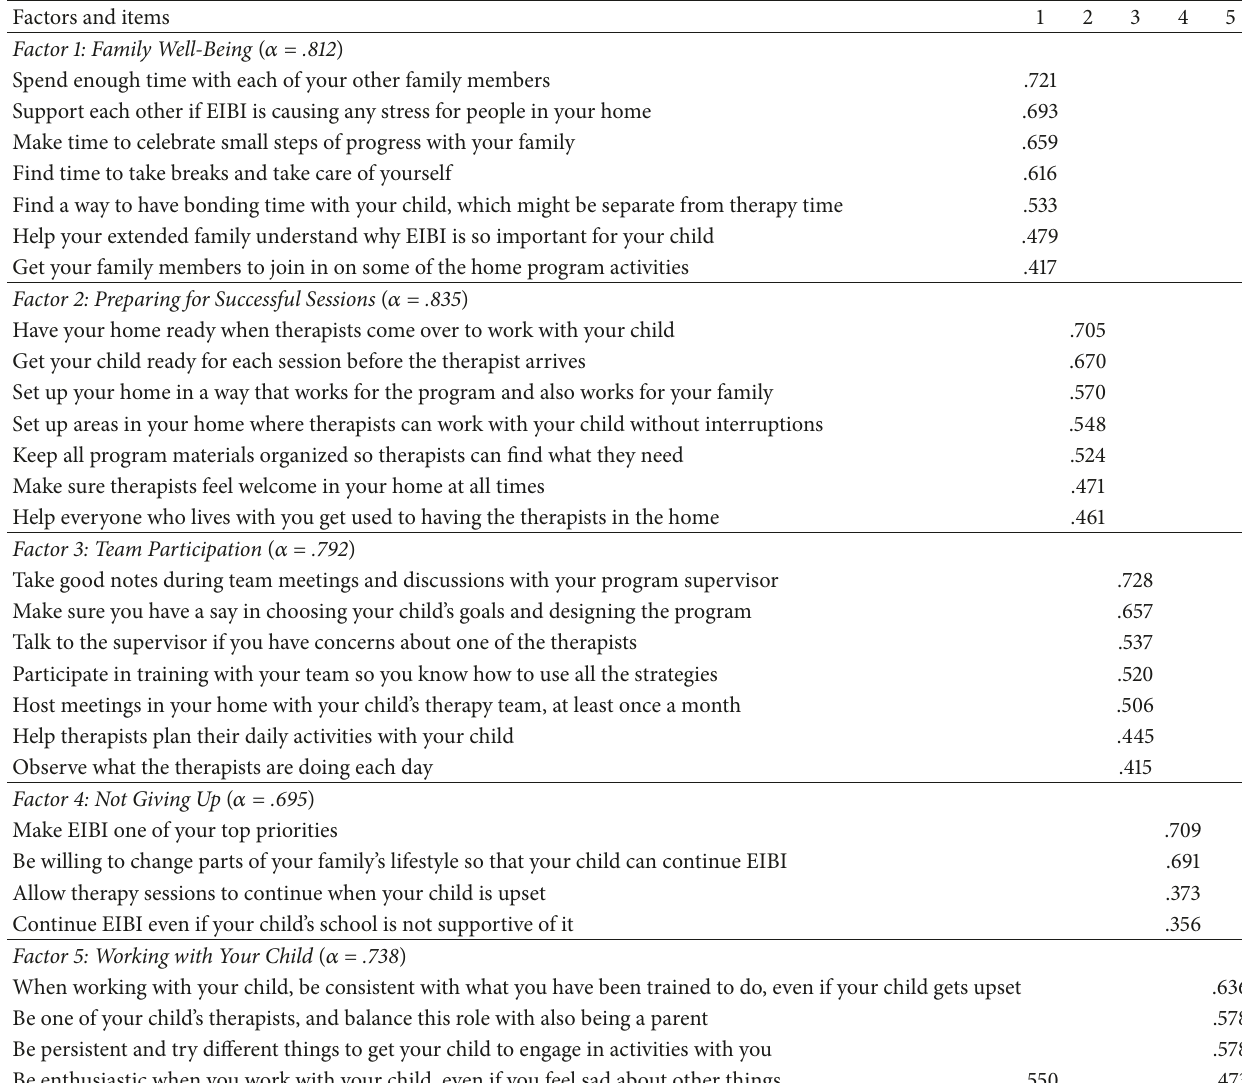
Table 2: Factor loadings with orthogonal rotation for the final five